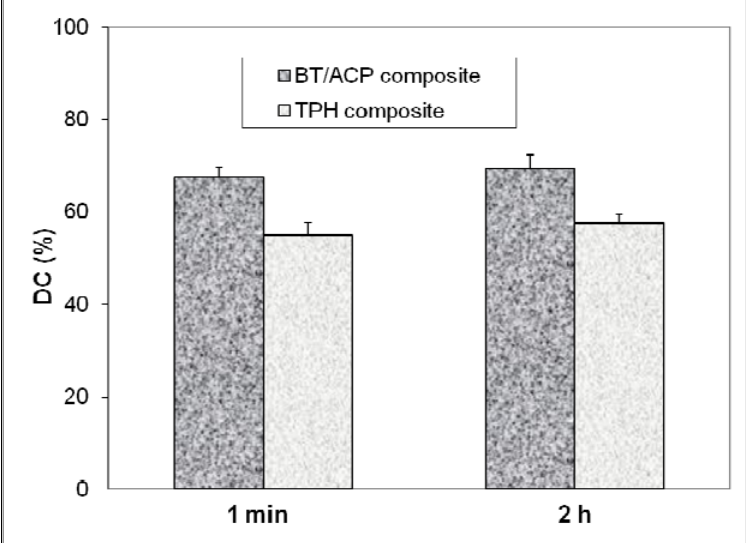
Figure 5. Degree of conversion (DC) attained 1 min and 2 h after visible light-curing of the BT/ACP and TPH composites, with the mean values of three repetitive measurements in each group; SDs are